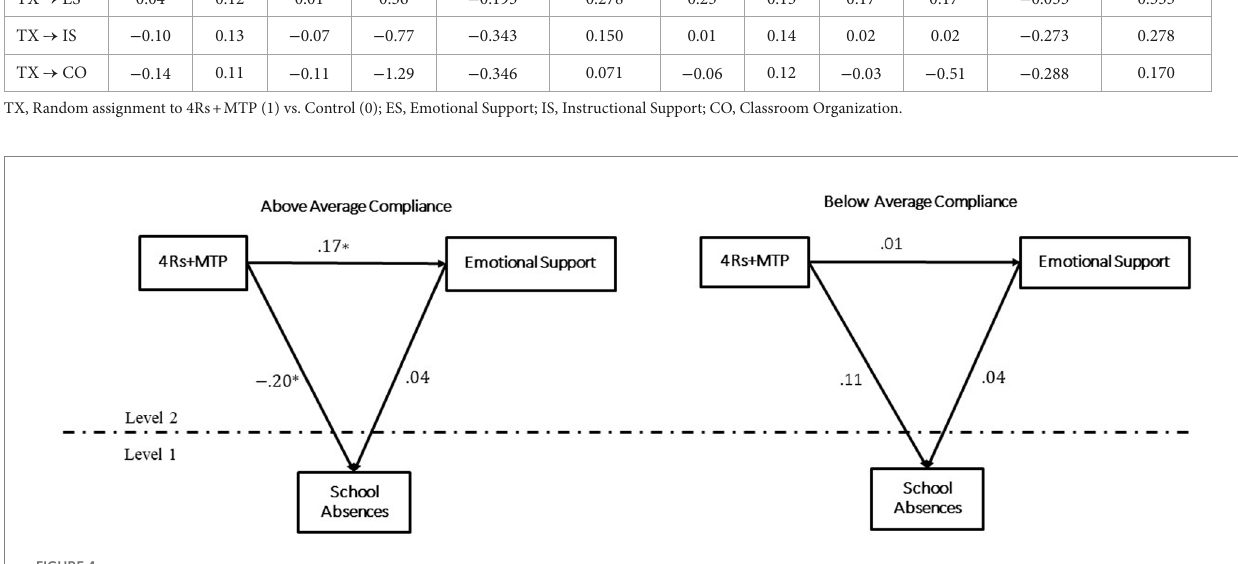
FIGURE 4 Mediation of quality of classroom interactions in the effect of random assignment to 4Rs + MTP on child school absences at different levels of teacher compliance